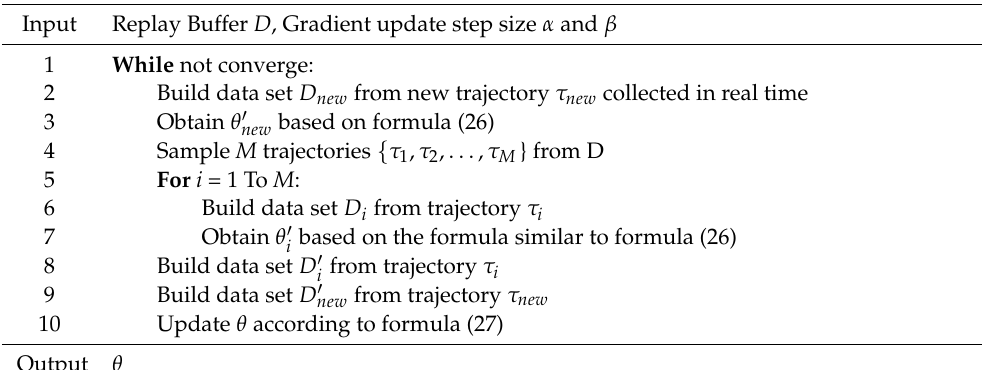
Algorithm 1 . Online learning of the model based on meta